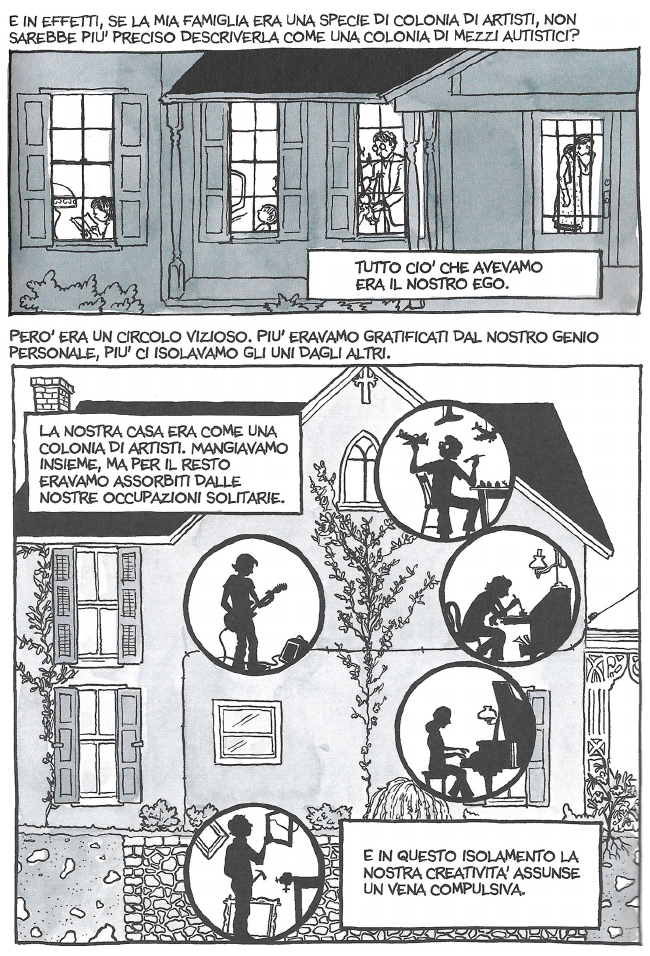
243 www.img-network.it